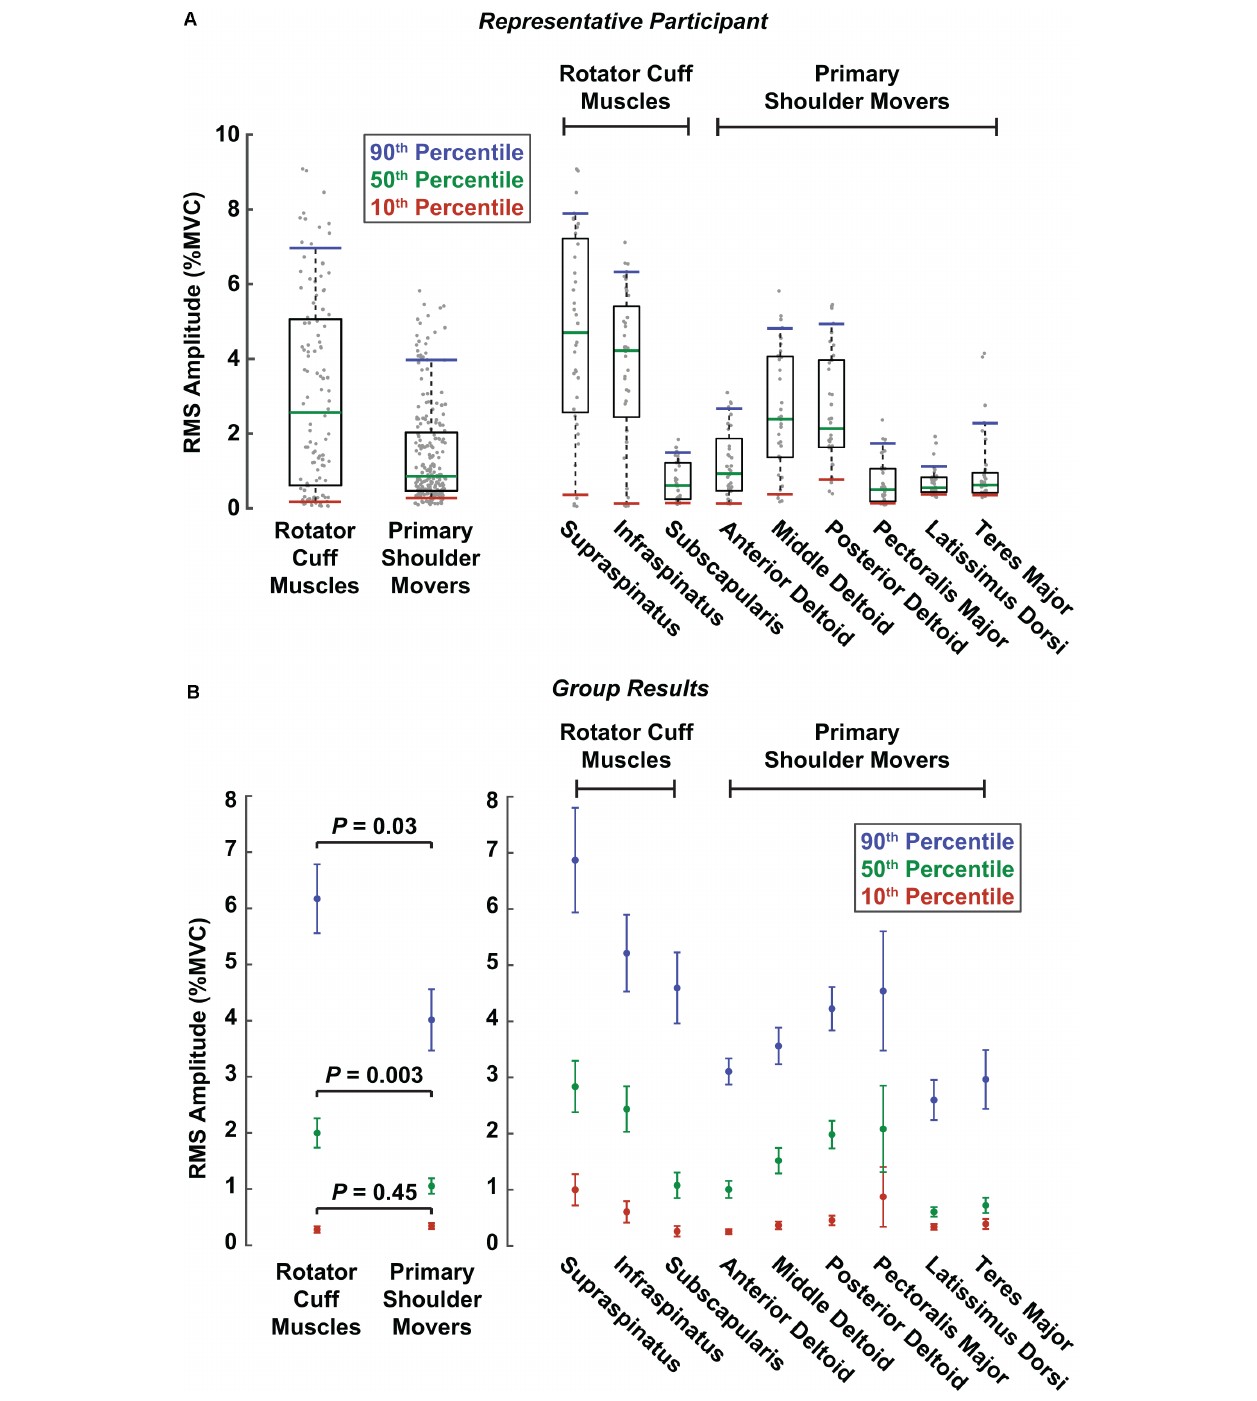
FIGURE 4 | Reflex amplitudes comparing muscle groups and individual muscles. Reflex amplitudes were summarized as RMS amplitudes, which were calculated from the root mean square of the reflexes in each perturbation direction for an individual trial. Colored lines represent the RMS amplitudes corresponding to the 10th (red), 50th (green), and 90th (blue) percentiles across all trials at torque levels of 10% MVC. The three percentiles correspond approximately to the small, median, and large amplitudes across all trials, respectively, for a given muscle or muscle group. (A) RMS amplitudes are displayed for a representative participant. Gray dots represent RMS amplitudes from all the participant’s individual trials in both perturbation directions for a given muscle or muscle group. The boxes represent the interquartile range (25th and 75th percentiles), and the whiskers span from the 10th to 90th percentiles. (B) RMS amplitudes for all participants. Error bars represent the standard errors of the RMS amplitude estimates at each respective